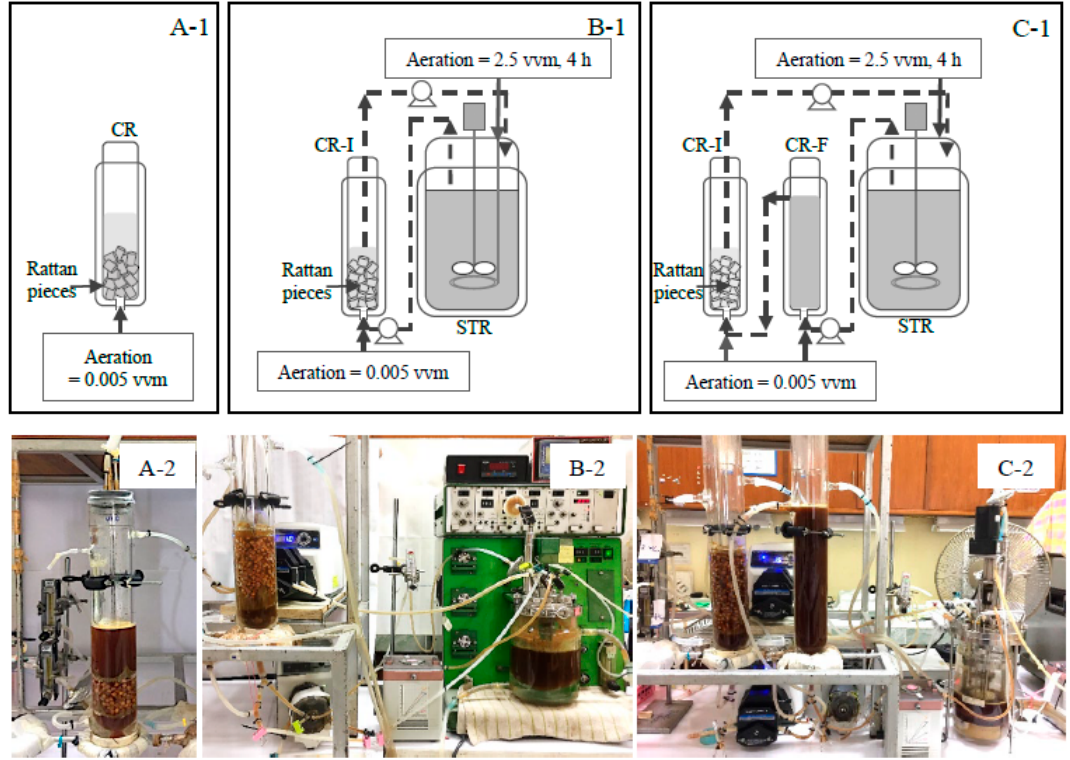
Figure 1. Schematic diagrams and images of ethanol fermentation using only CR ( A-1 , A-2 ), System I: STR coupled with CR-I ( B-1 , B-2 ). System Ⅱ : STR coupled with CR-F and CR-I ( C-1 , C-2 ). I: STR coupled with CR‑I ( B‑1 , B‑2 ). System II: STR coupled with CR‑F and CR‑I ( C‑1 , C‑2